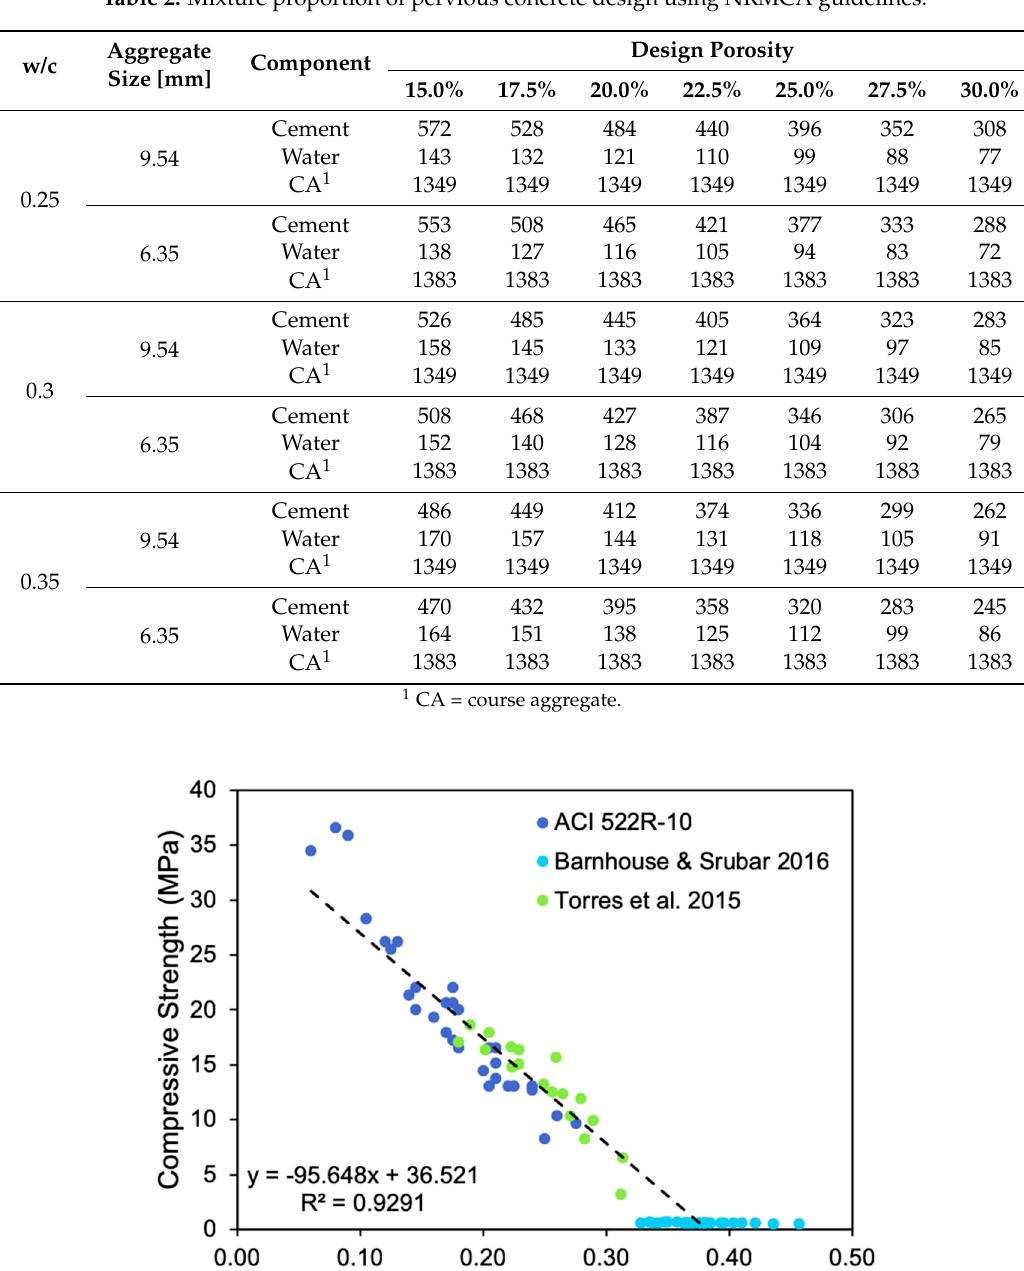
Table 2. Mixture proportion of pervious concrete design using NRMCA guidelines.